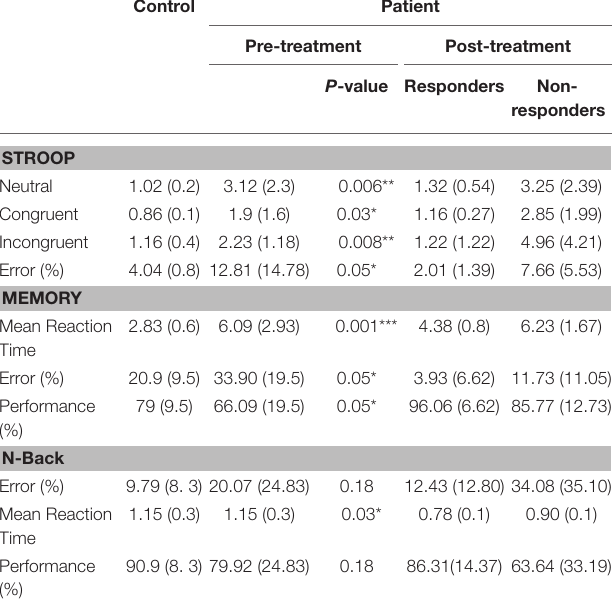
TABLE 6 | Cognitive test scores [Mean (SD)] in controls, Patients pre and post [responders (n = 8) and non-responders (n = 4)] 6 months Bumetanide administration.